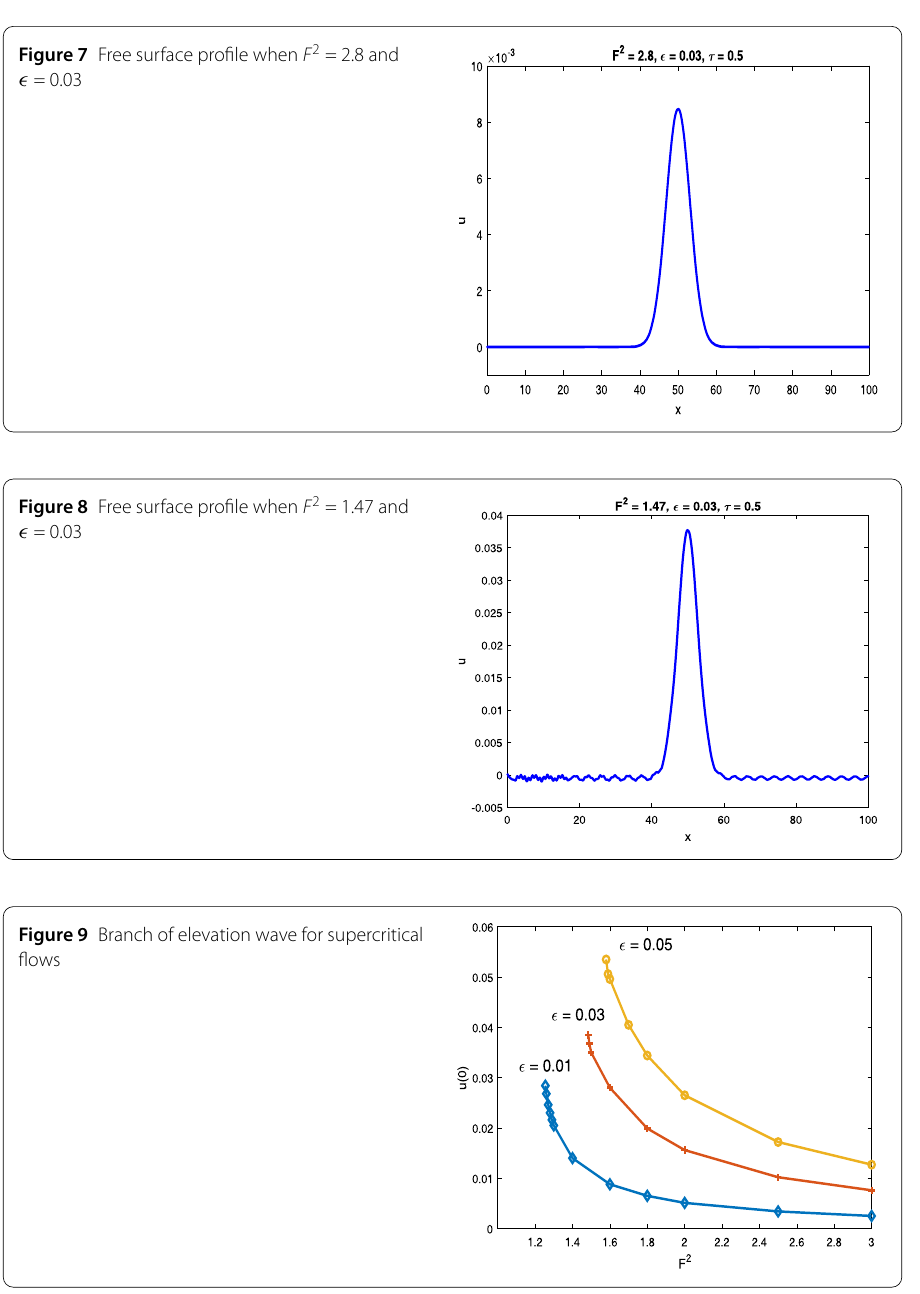
Figure 7 Free surface profile when F 2 = 2.8 and (cid:7) = 0.03